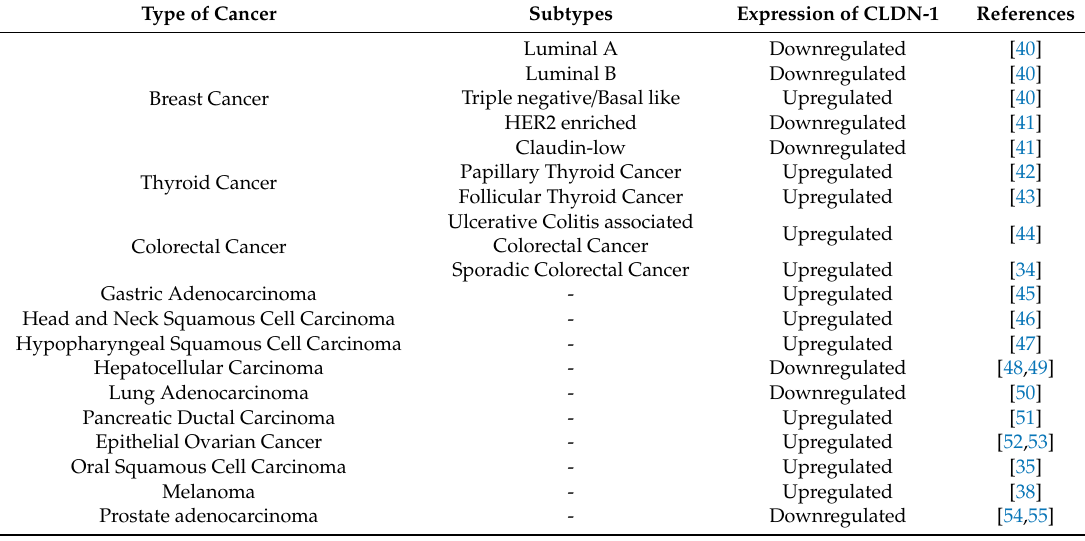
Table 1. Expression of CLDN-1 in di ff erent types of cancer.